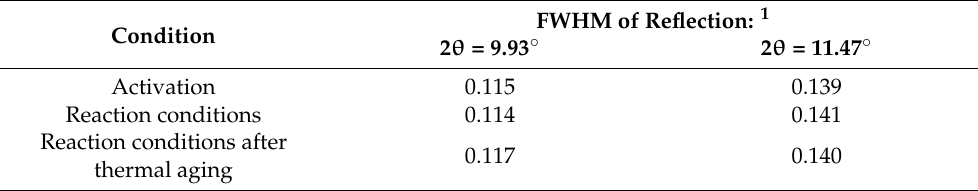
Table 1. Comparison of the fitted full width at half maximum (FWHM) of two Ni